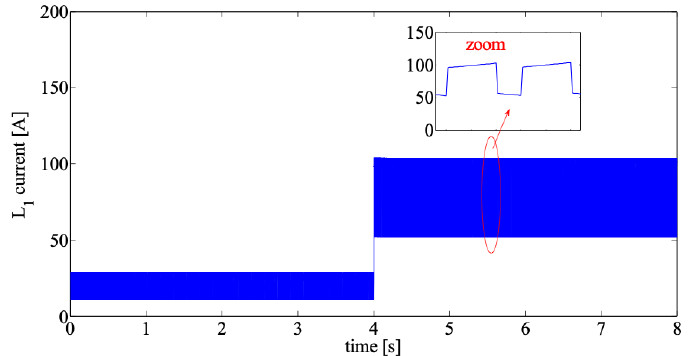
Figure 11. Magnetizing current (case A).